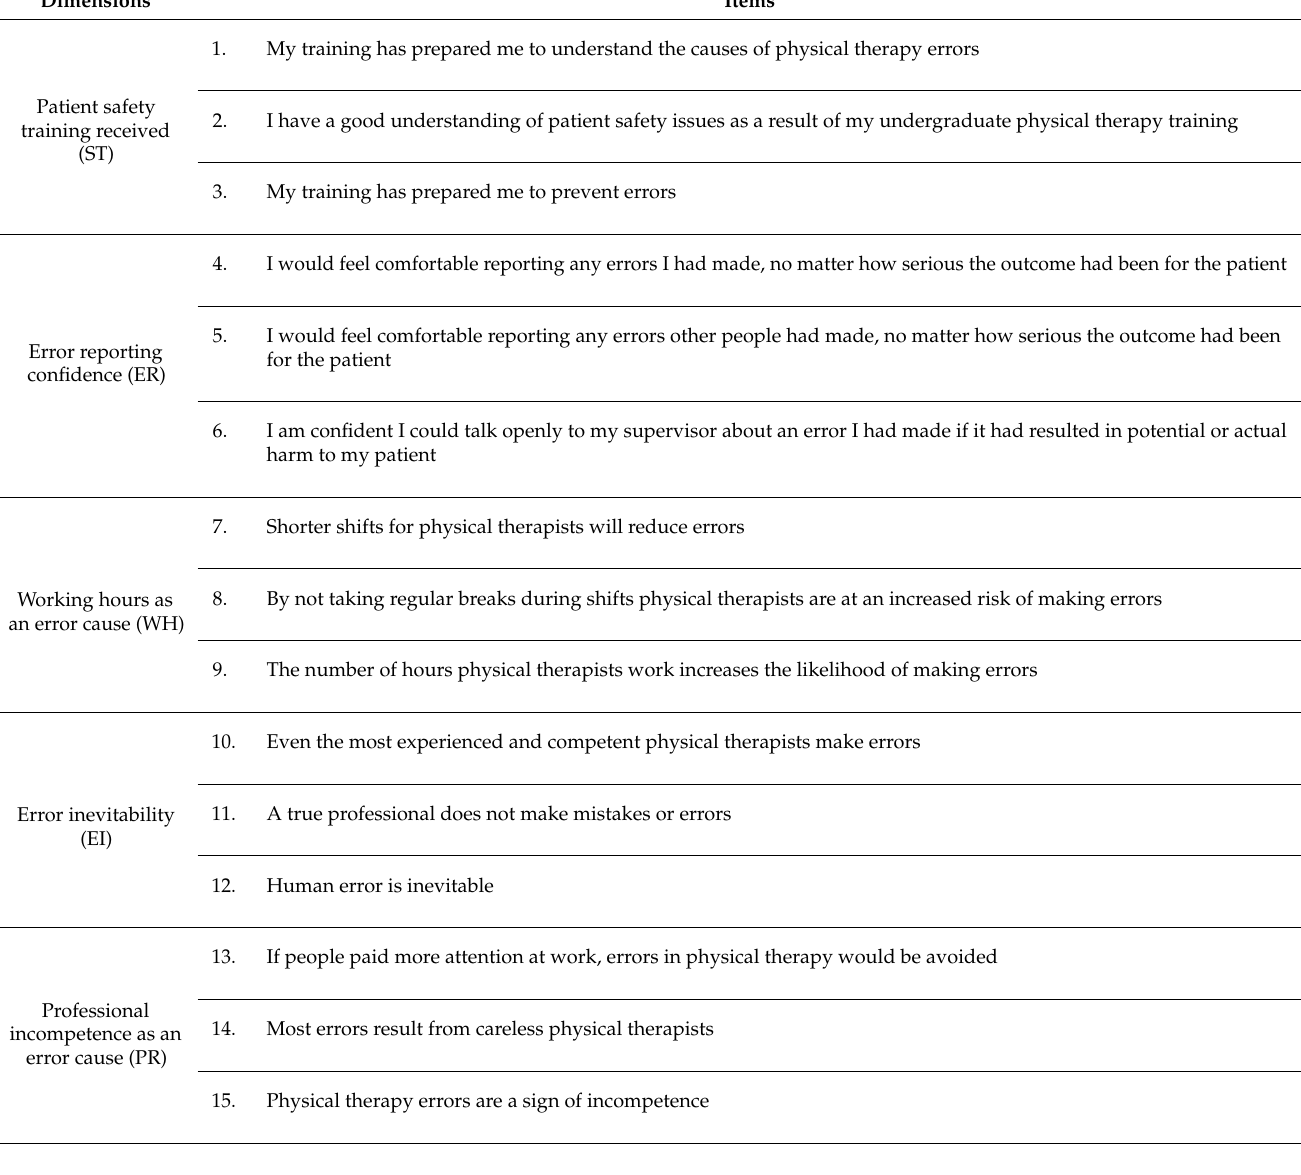
Table A1. Attitudes to Patient Safety Questionnaire (APSQ-III): Adaptation to Physical Therapy education [21] from the original version